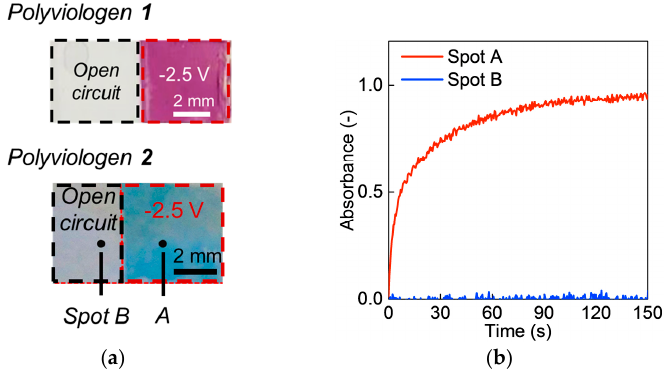
Figure 7. ( a ) Photograph of electrochromic cells containing 35 mM EMIM TCB in 5CB as electrolyte solution. The cell configuration is shown in Figure 5b; ( b ) Time dependence of absorbance at spot A and B (wavelength: 420